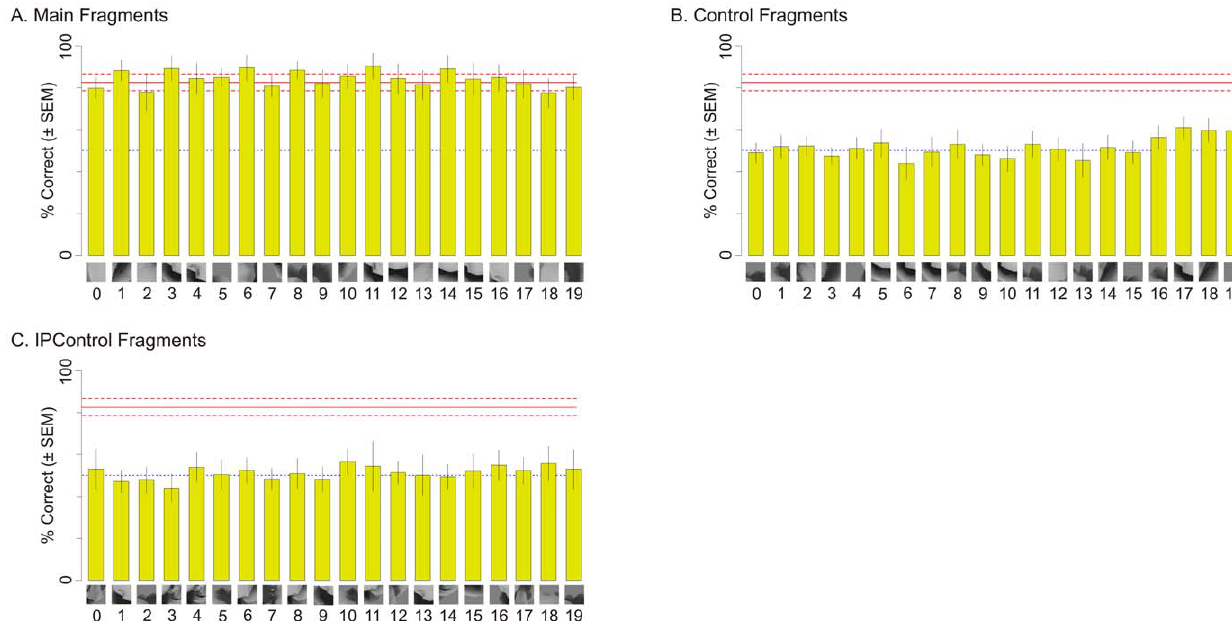
Figure 5. Performance of the animals in Experiment 1. Each bar shows the average percentage ( 6 SEM) of trials in which the animals classified a given object as belonging to class X given the corresponding fragment. The dotted blue line denotes 50%, or chance level performance. The light red lines denote the mean (solid line) and 6 SEM (dashed lines) performance of the animals during the respective last four blocks of training. Panels ( A ), ( B ) and ( C ) show the responses of the animals in the Main task ( i.e ., X vs . Y) using Main, Control and IPControl fragments respectively. With each Main fragment, the performance was significantly above chance (binomial tests, p , 0.05), and indistinguishable from the performance using whole objects (binomial tests, p . 0.05, data not